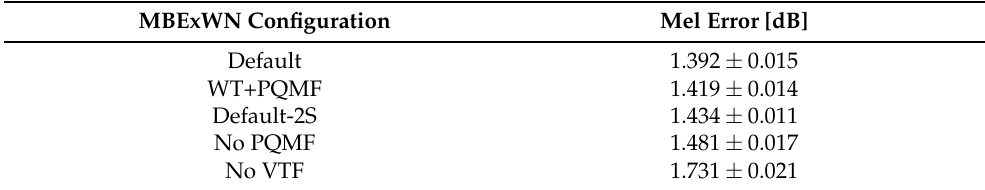
Table 2. Results of the ablation study. The mel reconstruction error is shown together with the 95% confidence